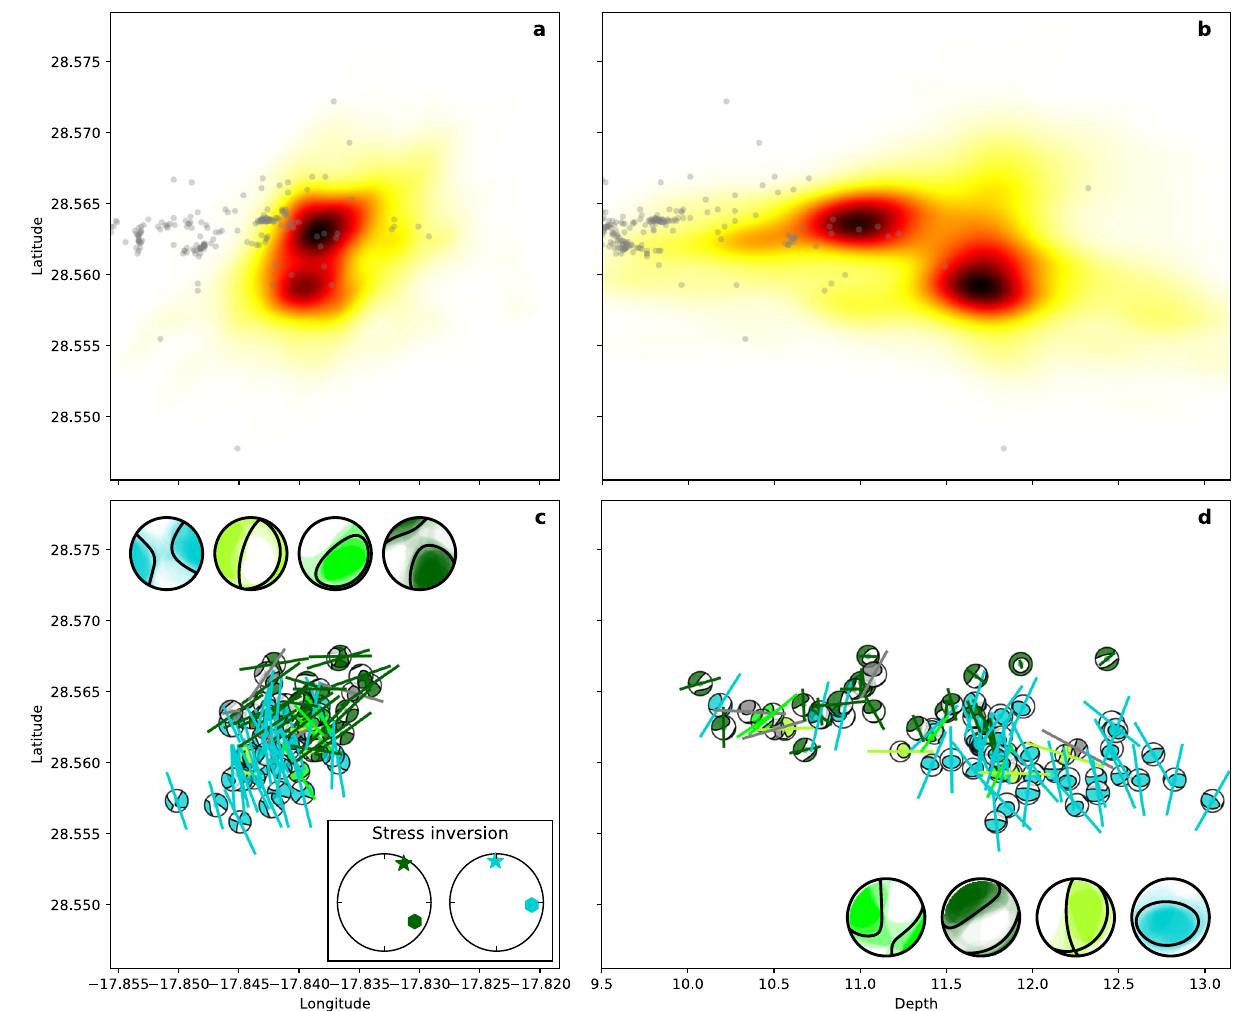
Fig. 4 | Seismicity distribution at the shallow cluster. a Normalised density of relocated hypocentres (darker regions corresponding to higher density) in map viewand b verticallybylatitude;hypocentrallocationofearthquakesassociatedto the dike intrusion are shown in grey. c Moment tensor solutions (small focal spheres) in mapview. Focal spheres are coloured according to the moment tensor clustering, with four clusters identi fi ed, plus a few unclustered moment tensors (grey). Thick lines show the projection of the corresponding pressure axes. Large